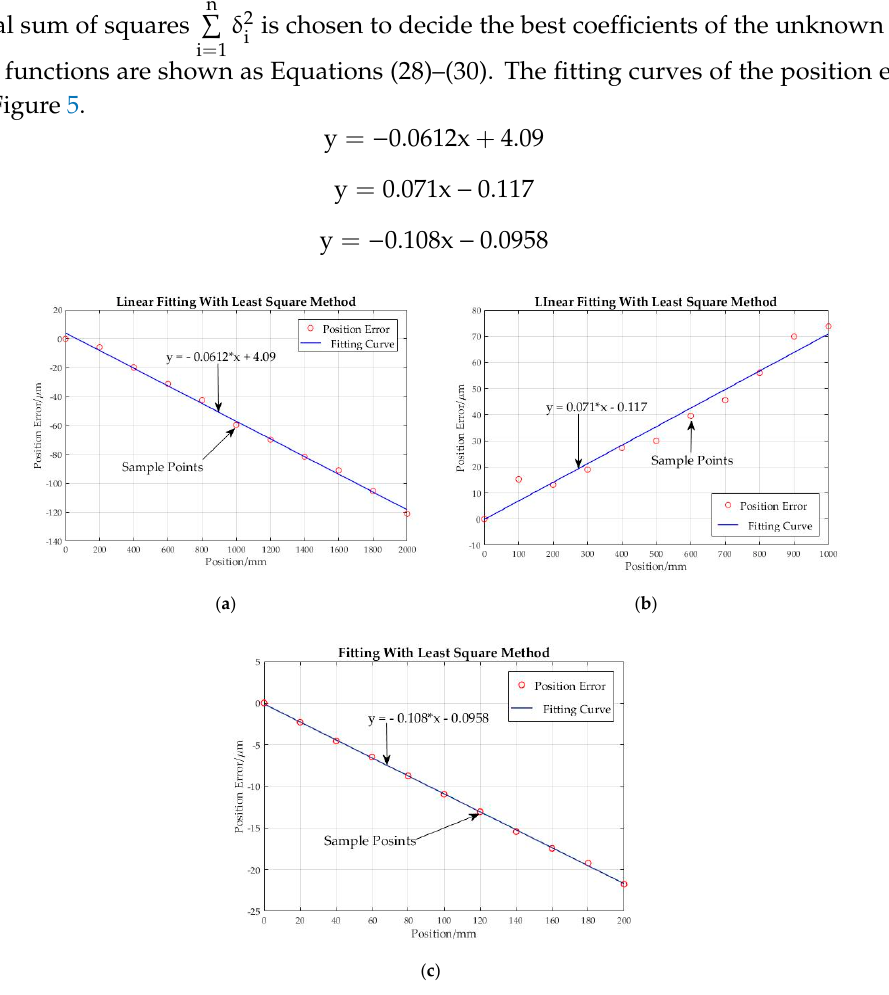
Figure 5. Image of fitting curves. ( a ) Fitting curve of X-direction position error; ( b ) Fitting curve of Y-direction position error; ( c ) Fitting curve of Z-direction position error.